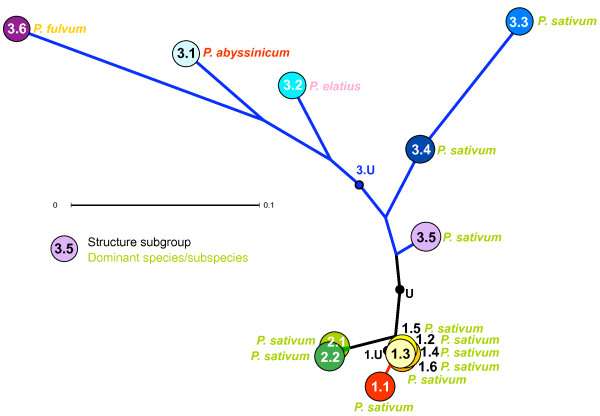
Distance-based estimations for Structure Sub-Groups. A neighbor joining tree of the genetic distance between Sub-Groups was calculated from the combined allele frequencies per Sub-Group, using Nei's method [40]. Structure Sub-groups are colour coded as in Figure 4 and predominant species in each Sub-Group (Additional file 2) are indicated by coloured text using the same species-specific colours as Figure 4.